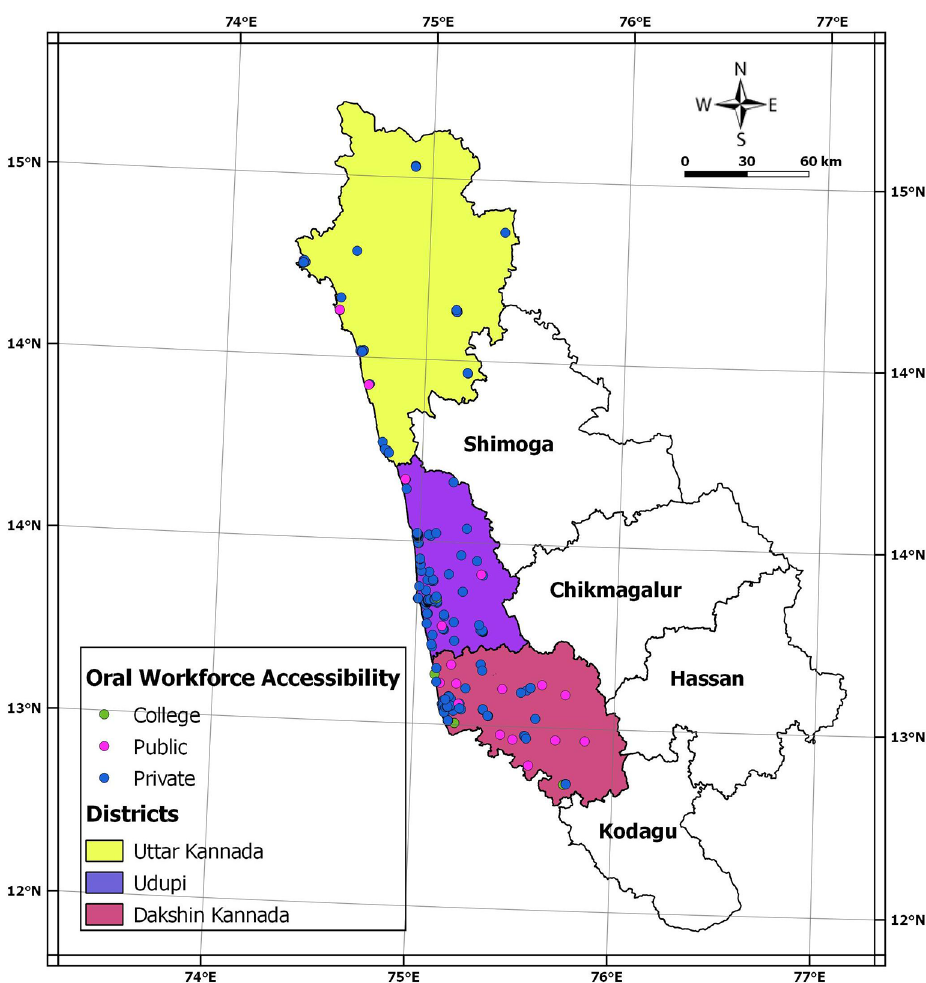
Figure2.Geo-mappingoftheprivateandpublicoralhealthcarefacilitiesandDentalschooldistributioninthe three coastal districts of Karnataka.